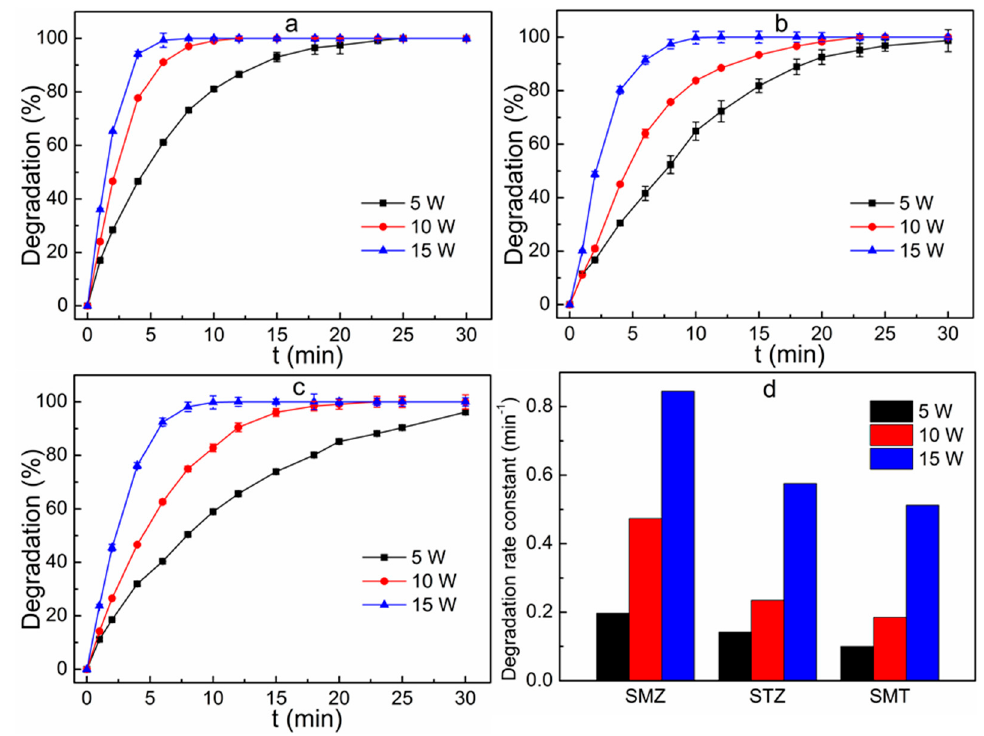
Figure 3. Effect of UV light intensity on the removal of SMZ ( a ), STZ ( b ) and SMT ( c ) and degradation rate constants for sulfonamides degradation at different UV light intensity ( d ). Reaction conditions: initial concentration of the mixed solution 100 μ g L − 1 , H 2 O 2 dosage 55 mg L − 1 .